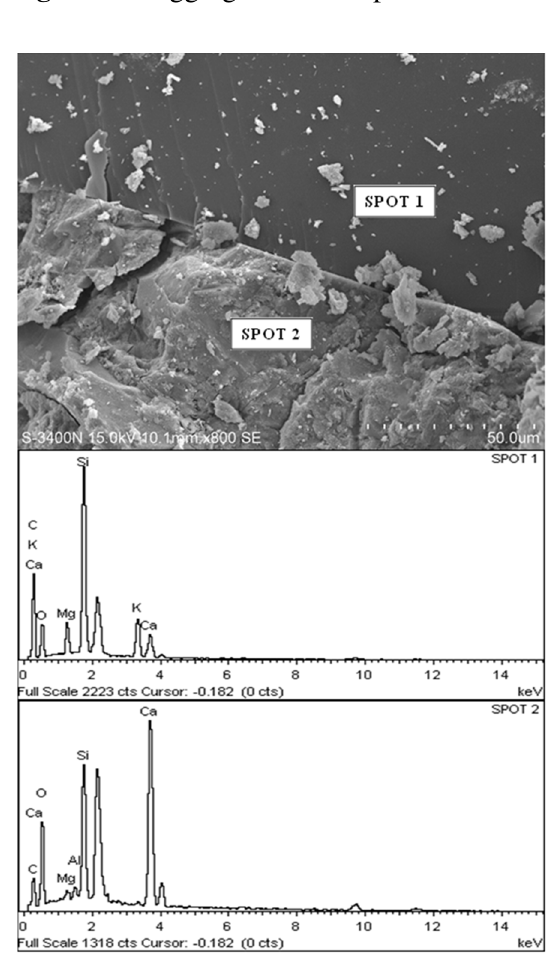
Figure 17. POC aggregate—Cement paste interface with X-ray spectroscopy (EDX).